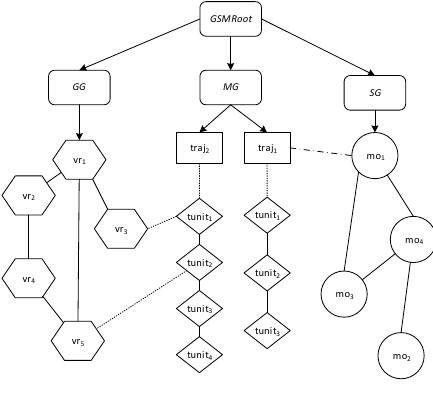
Figure 6. Implementation of the GSM